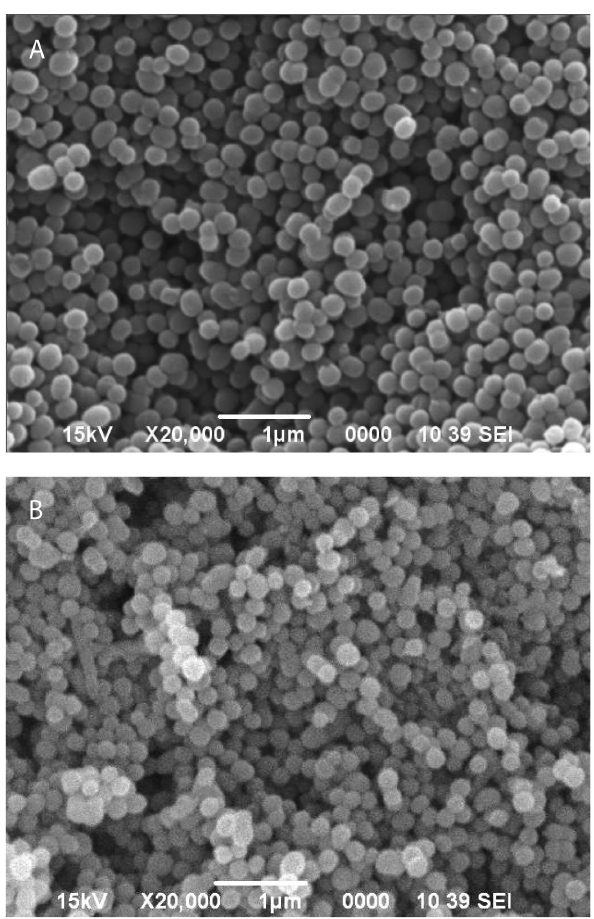
Fig. 1: SEM image of the aluminum ompounds obtained by reflux method, using aqueous solution, containing 7 × 10 − 3 mol/L aluminum nitrate, 3.5 × 10 − 3 mol/L potassium sulphate and 1.25 × 10 − 1 mol/L urea, (A) as prepared and (B) calcined at 1000